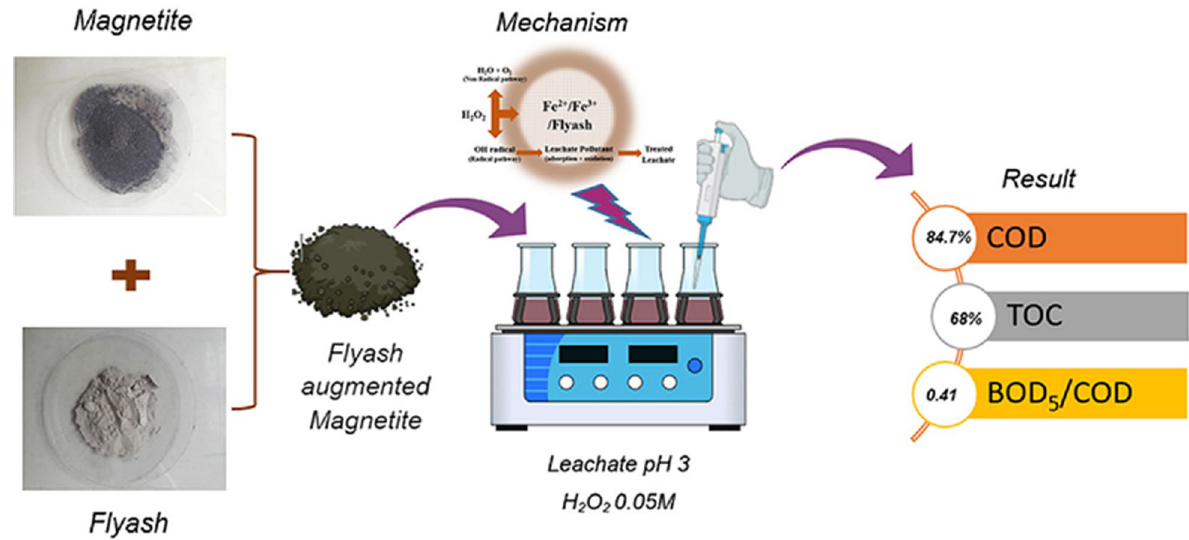
Fig. 13 Fe 3 O 4 augmented fly ash for POP removal (Niveditha et al. 2020)